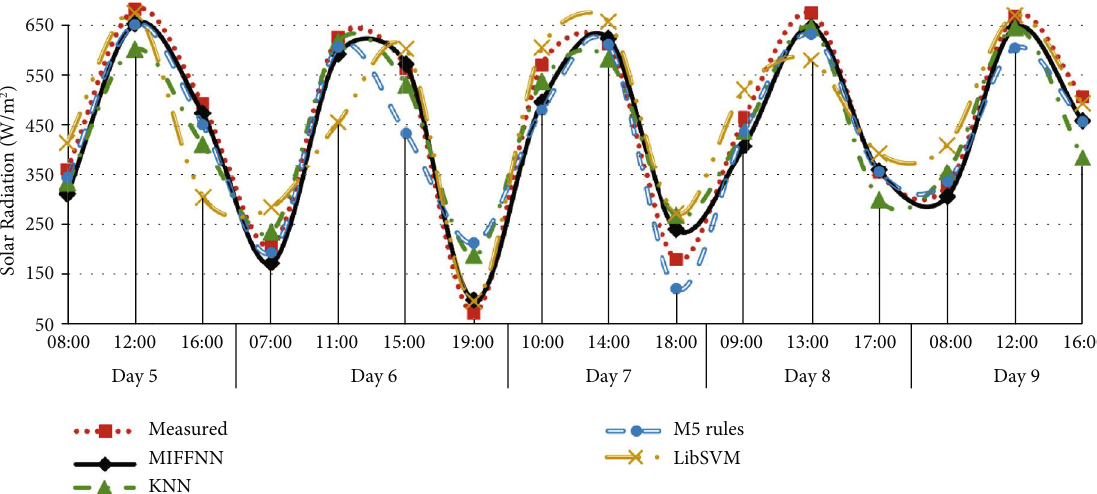
Figure 17: Comparative performance plot of ML algorithm models measured and estimated by using fi ve-day input data from July 2004 in Isparta according to HAGSR